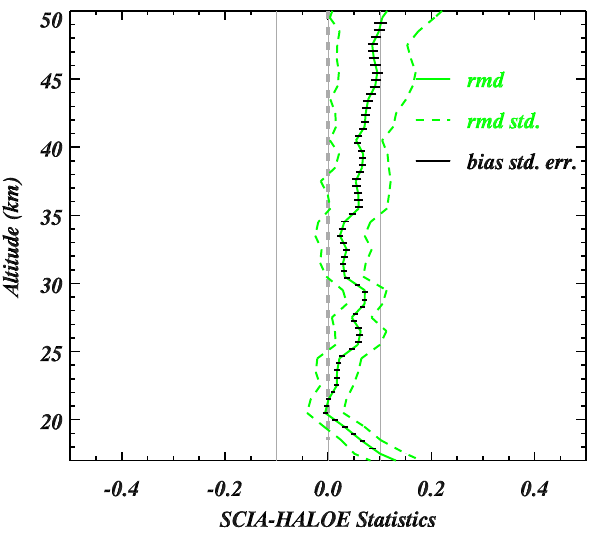
Fig. 14. SCIAMACHY–HALOE comparison statistics for the pe- riod 2003–2005 based on 52 collocations with HALOE sunrise events (none was found with the sunset events).